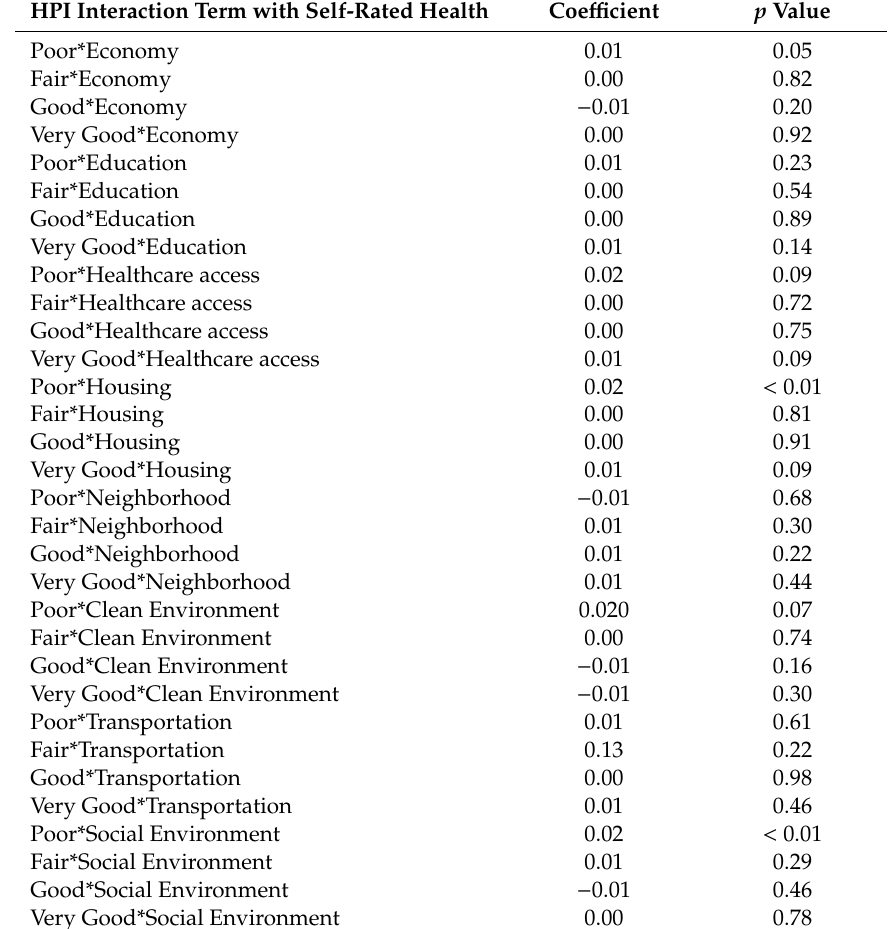
Table 4. Disaster preparedness vs. self-rated health with the HPI a domain interactions, Los Angeles County, 2013 ( n = 4700) b